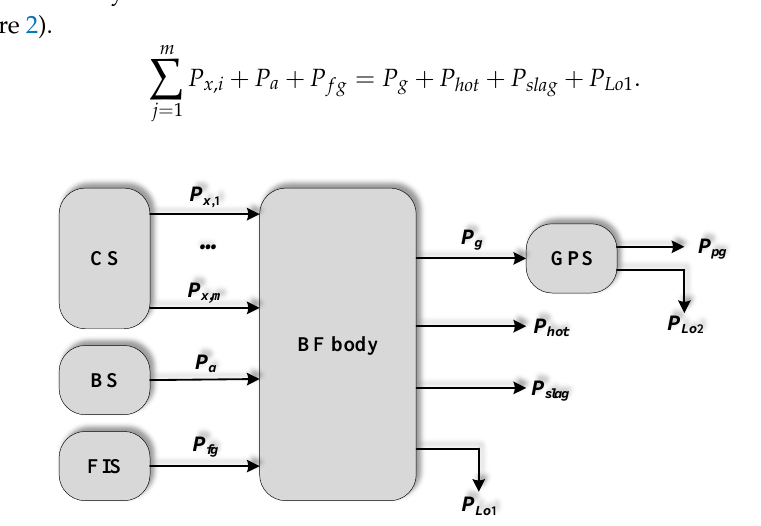
Figure 2. Material flows analysis model